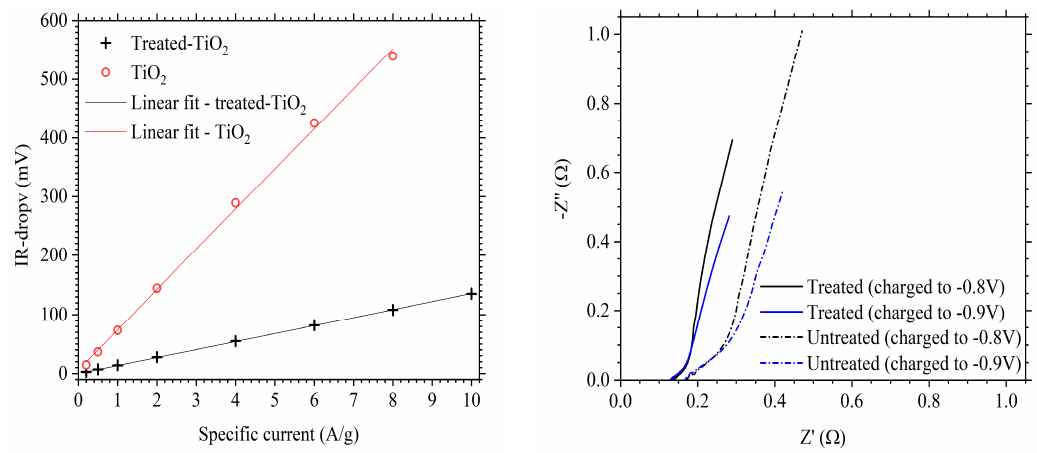
Figure 7. ( a ) Comparison of IR-drop, between charge and discharge, for treated-TiO 2 (black cross) and TiO 2 (red circle) as a function of specific current; ( b ) Nyquist plot of a TiO 2 (dash-dot line) and treated-TiO 2 (solid line) electrode. Measurements were taken between 0.1 Hz–10 kHz, at open circuit potential (OCP), after charging to − 0.8 V (black) and − 0.9 V (blue) vs. SCE.